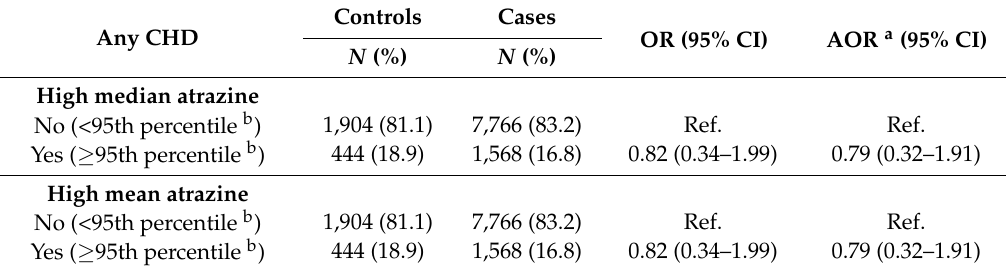
Table 4. Association between estimated atrazine exposure in drinking water and congenital heart defects in offspring in Texas, 1999–2005, among districts with population size >200,000. Controls Cases Any CHD OR (95% CI) AOR a (95% CI) N